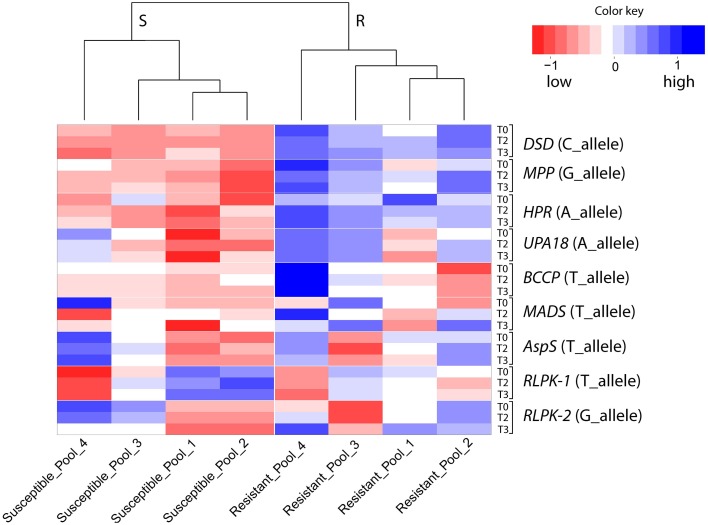
Heatmap showing SNP allele specific expression in resistant and susceptible pools at infection time points T0, T2, and T3 as quantified by pyrosequencing. Columns represent the resistant (R) and susceptible (S) genotype pools. Rows represent the expression (average of three infection experiments) at T0, T2, and T3 of the SNP allele that was expressed at higher level in the resistant pool A2 compared with pools A1 and B2 in SuperSAGE (Supplemental File S4). The eight genes with contrasting allele expression are indicated to the right. Increasing and decreasing expression is indicated by blue and red colors, respectively. Numerical data are shown in Supplemental File S6.